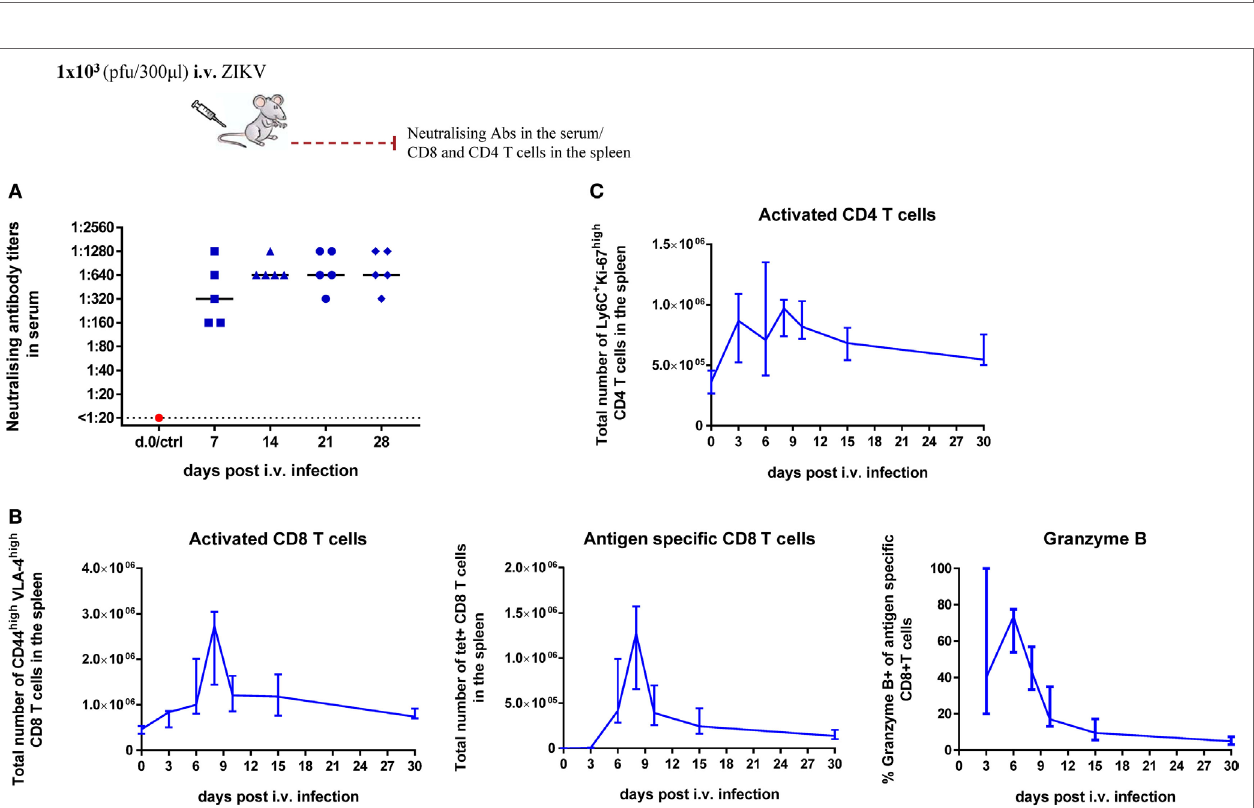
FigUre 4 | Graphical representation of our in vivo mouse model for Zika virus (ZIKV) infection. Mice are infected peripherally with low doses of ZIKV, and 4 weeks later, they are challenged i.c. with lethal doses of